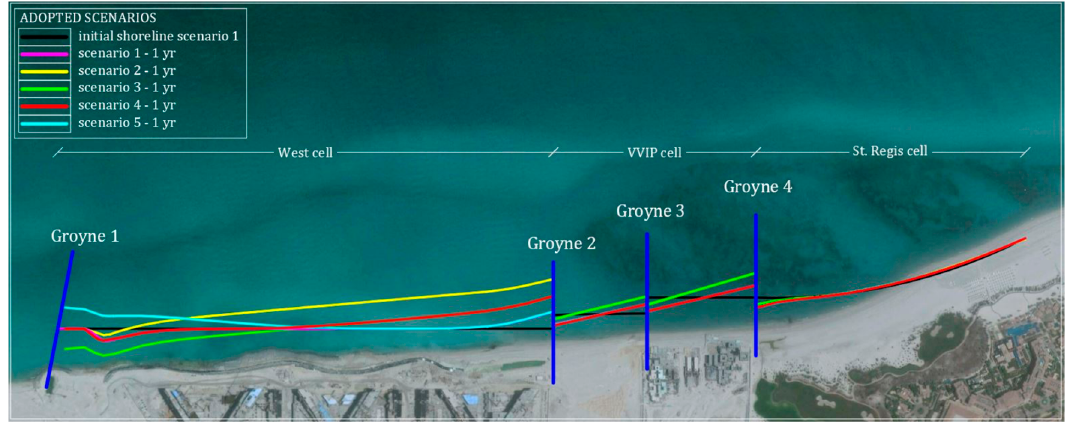
Figure 9. Evolution of the initial shoreline after 1 year, for the different considered the scenarios simulated.